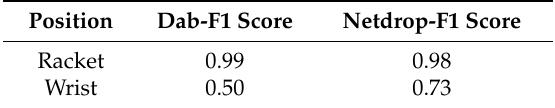
Table 6. Most optimal f1 score after varying score weights in ensemble learning.